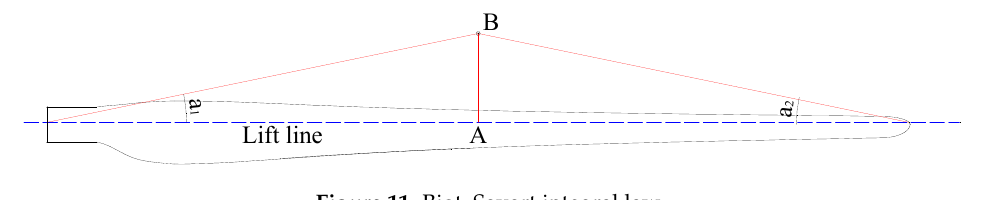
Figure 11. Biot–Savart integral law.